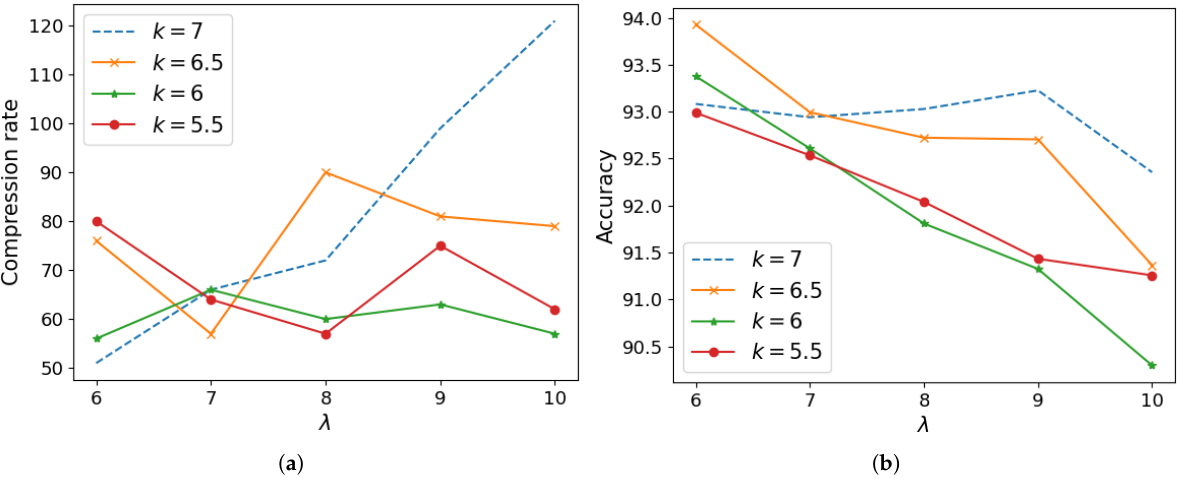
Figure 7. ( a ) The value of compression rate according to k and λ . ( b ) The value of accuracy according to k and λ . If k is small, the network cannot be compressed more, and performance decreases more, according to changing of λ . On the other hand, when k is sufficiently large, the network can be compressed with high compression rate, and accuracy drop is not too severe, according to changing of λ